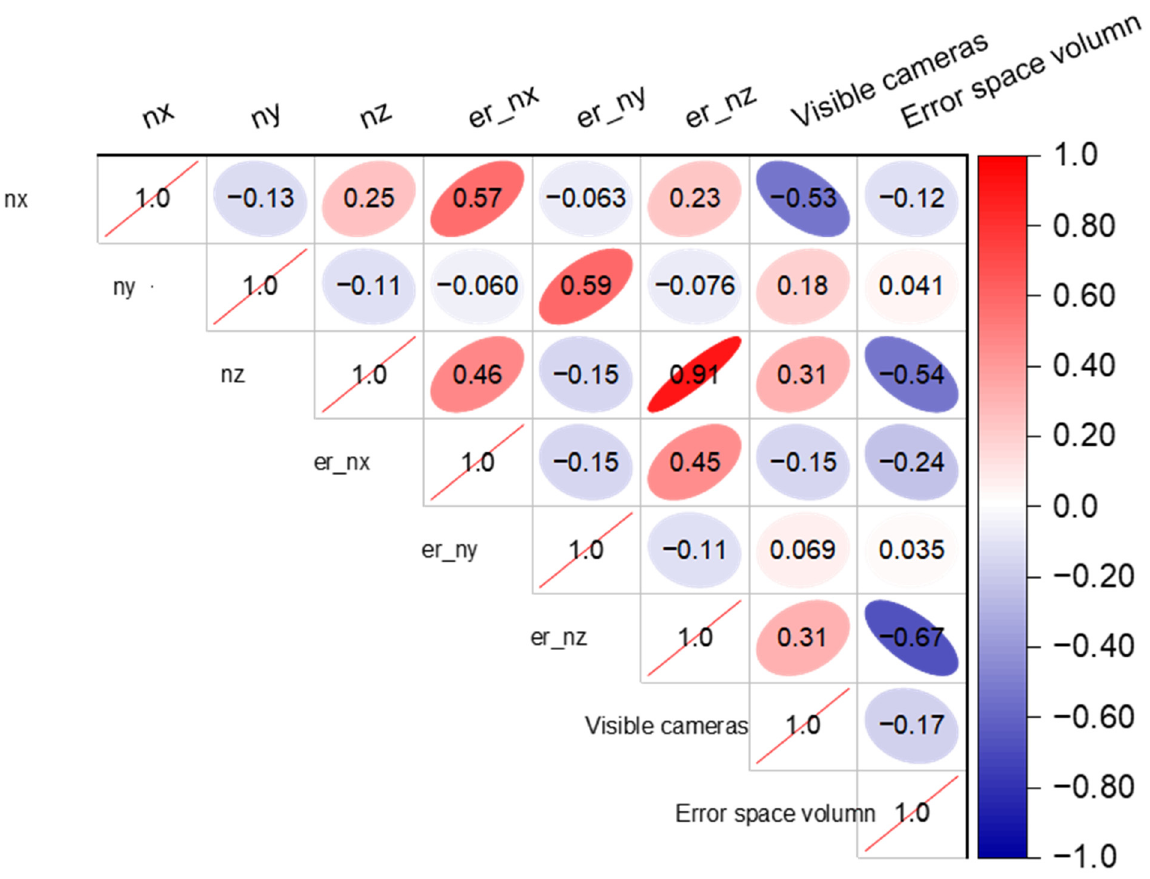
Figure 10. Pearson correlation coefficient matrix of key parameters.